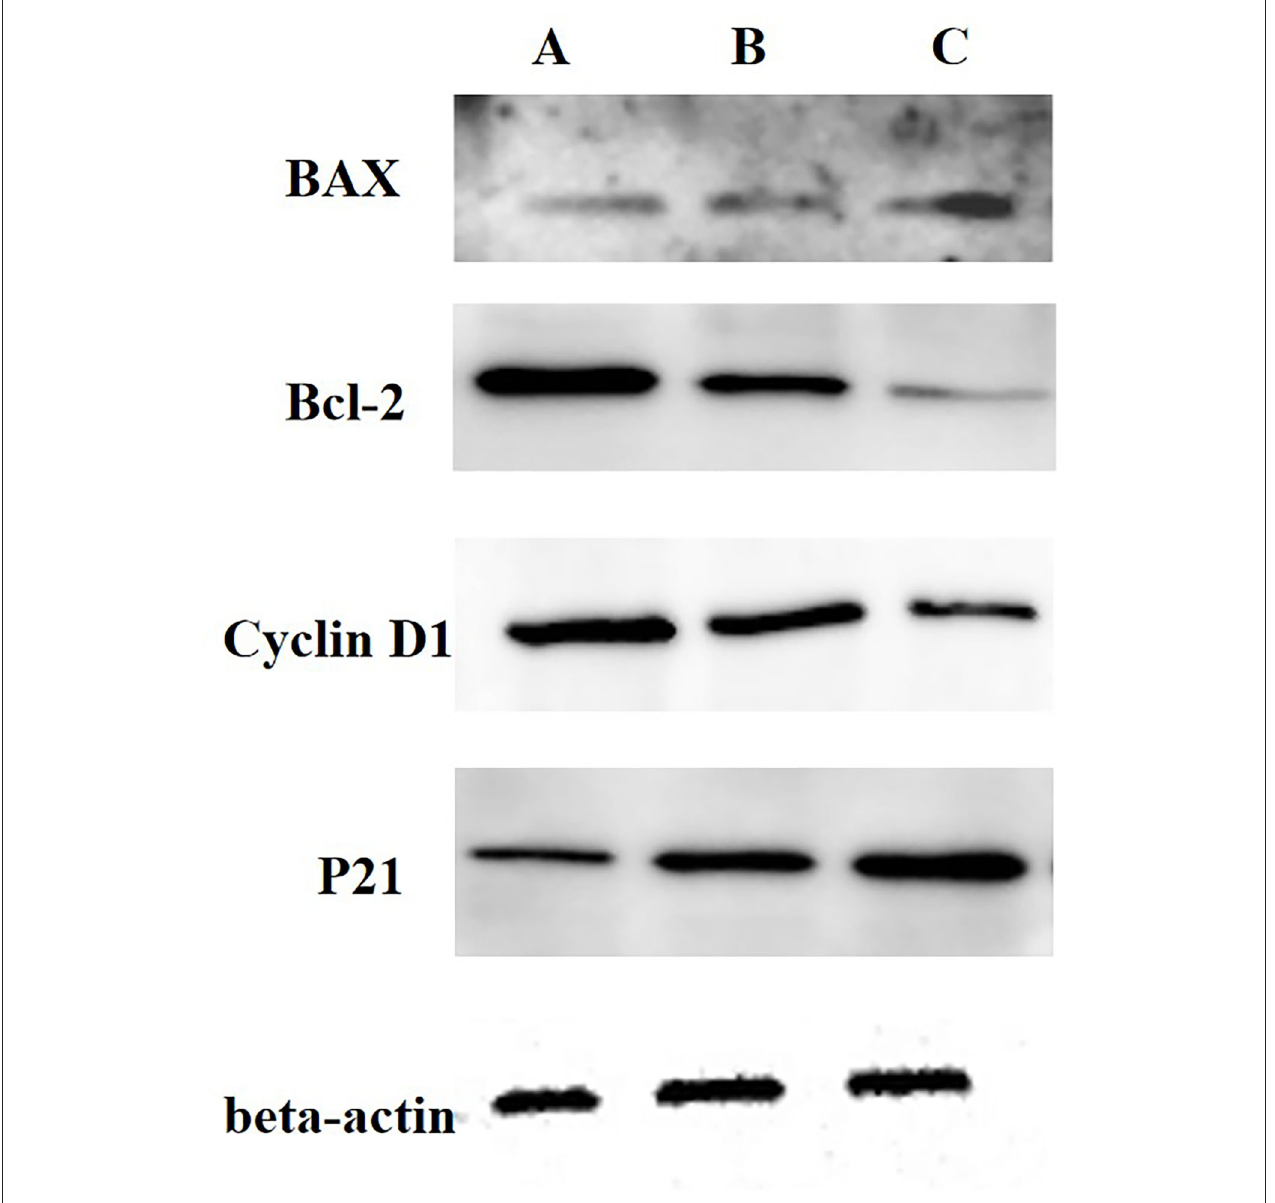
FIGURE 2 | Analysis of Cyclin D1, active p21, Bcl-2, and Bax expressions in DST using WB. IPEC-J2s were treated with 0.0, 0.5, or 2.0 mg/mL SBA for 24h. (A) control, 0.0 mg/mL SBA treatment; (B) 0.5 mg/mL SBA treatment; (C) 2.0 mg/mL SBA